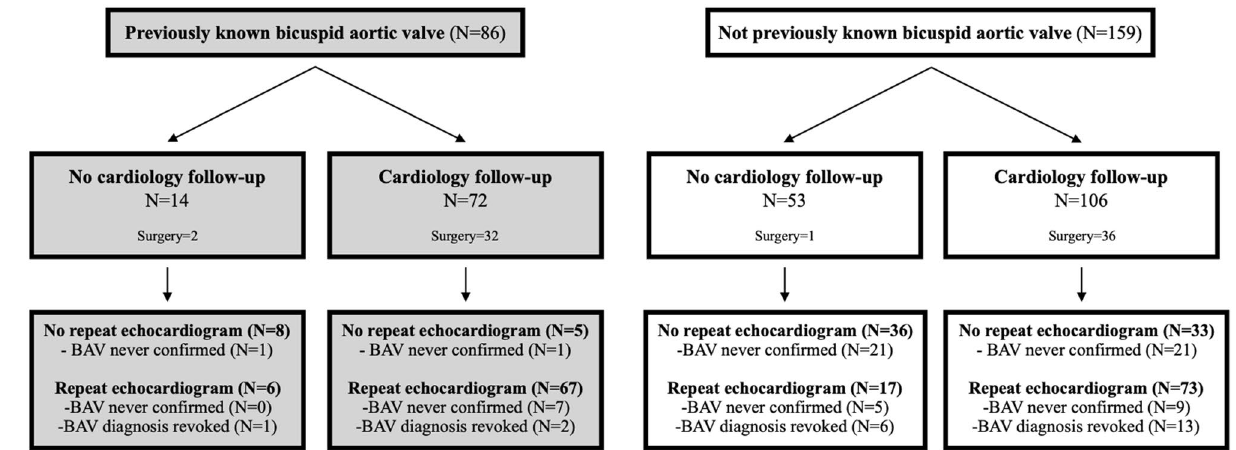
Figure 1. Follow-up patterns in patients diagnosed with bicuspid aortic valve by echocardiogram. Flow-chart of patient cardiology follow-up and echocardiogram studies following initial ECHO (2013–2018). Follow-up was determined if there was at least one recorded appointment with outpatient cardiology or outpatient cardiothoracic surgery following the initial ECHO in this study. Recorded follow-up lasted until January 2020. Unconfirmed BAV diagnosis was determined if the ECHO described the aortic valve as “cannot rule out bicuspid valve”, “possible bicuspid valve”, or “unclear if bicuspid” and further ECHO studies did not clarify. BAV reversal was determined if a follow-up echocardiogram stated “tricuspid aortic